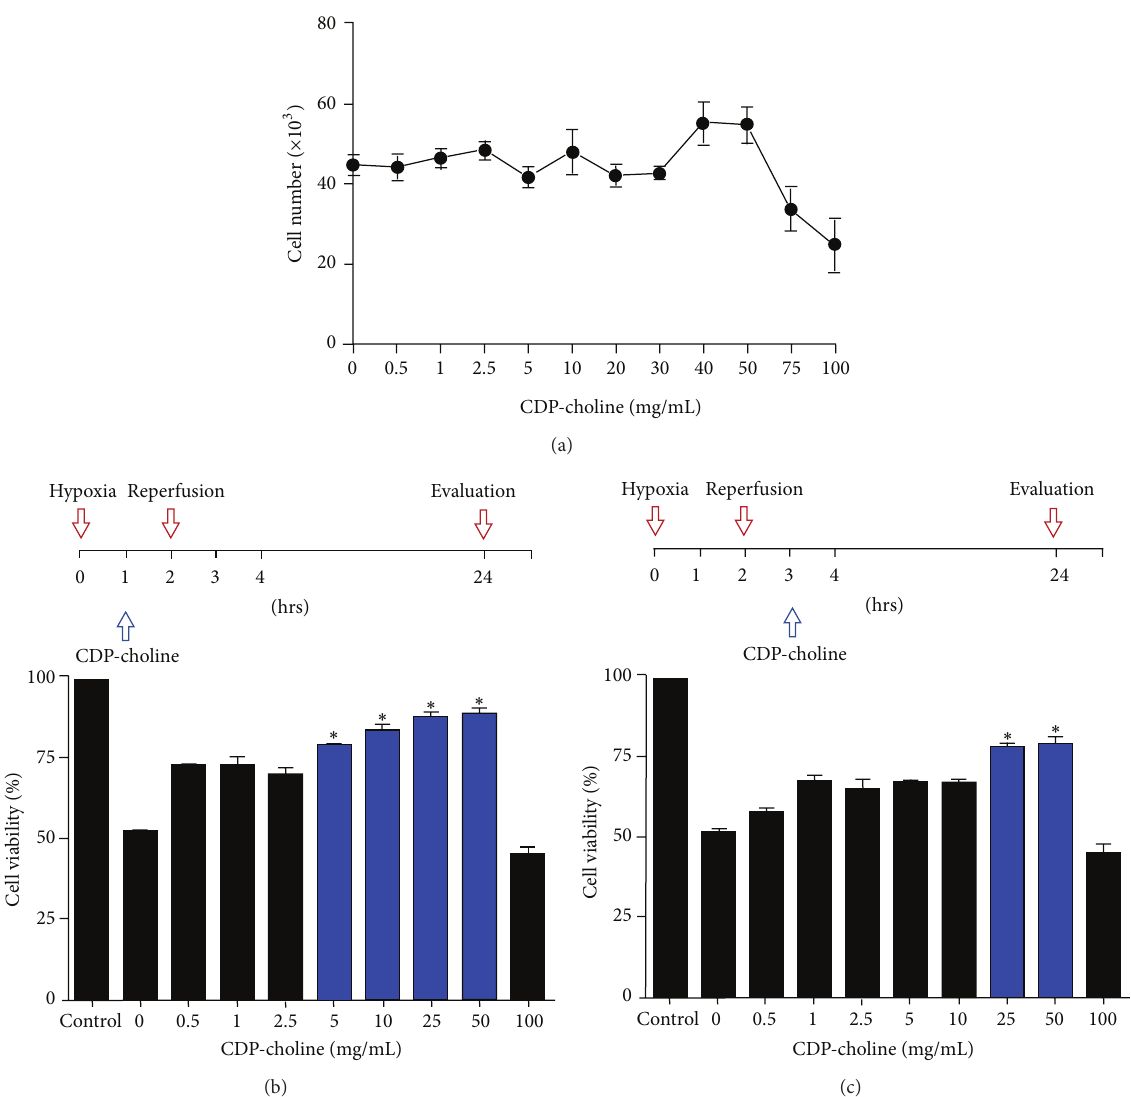
Figure 2: Effect of CDP-choline on cardiac myocytes survival. (a) Cardiac myocyte cultures were treated with increasing concentrations of CDP-choline as indicated. The proportion of viable cells was determined at 24 hrs using the MTT assay. (b) Effect of CDP-choline preconditioning. Cardiac myocytes were coverslipped for 2 hrs. The coverslip was then removed, and the cells were reperfused. CDP-choline was added to coverslipped cells 1hr prior to reperfusion at the indicated concentrations. Cell viability was assessed at 24 hrs using the MTT assay. (c) Effect of CDP-choline postconditioning. Cardiac myocytes were coverslipped for 2 hrs. The coverslip was then removed, and the cells were reperfused. CDP-choline was added 1hr after reperfusion. The proportion of viable cells was assessed at 24hrs using the MTT assay. All values reported represent the average of three independent tests. Error bars indicate the standard error of the mean. ∗ 𝑃 < 0.05 versus untreated control